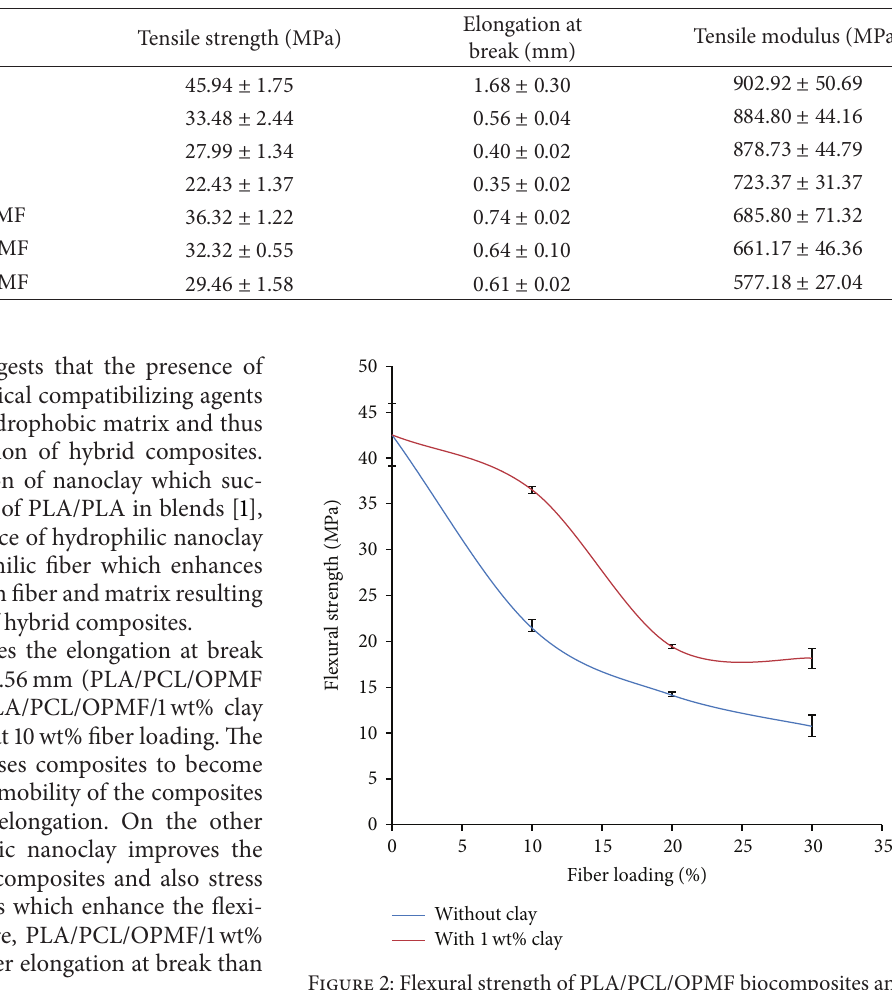
Figure 2: Flexural strength of PLA/PCL/OPMF biocomposites and PLA/PCL/1wt% clay/OPMF hybrid